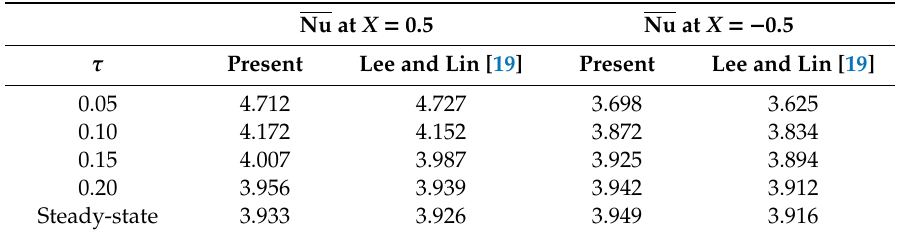
Table 1. Comparison of computed Nusselt number at hot wall between the present work and those from Lee and Lin [19].